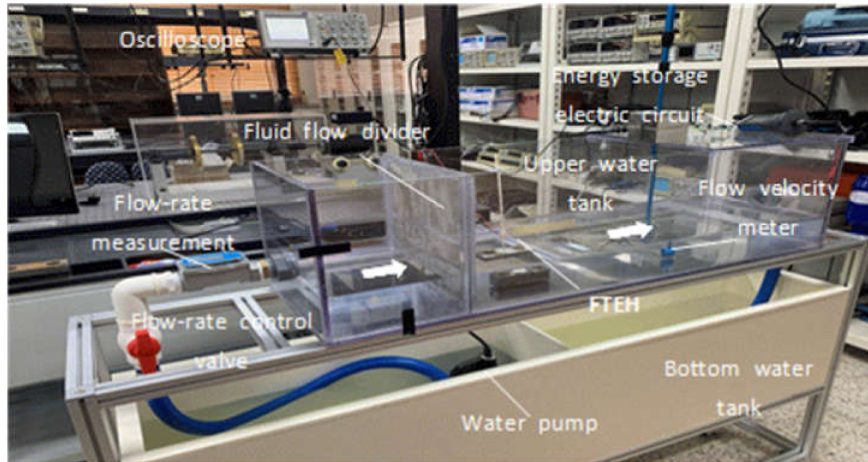
Figure 16. Experimental set